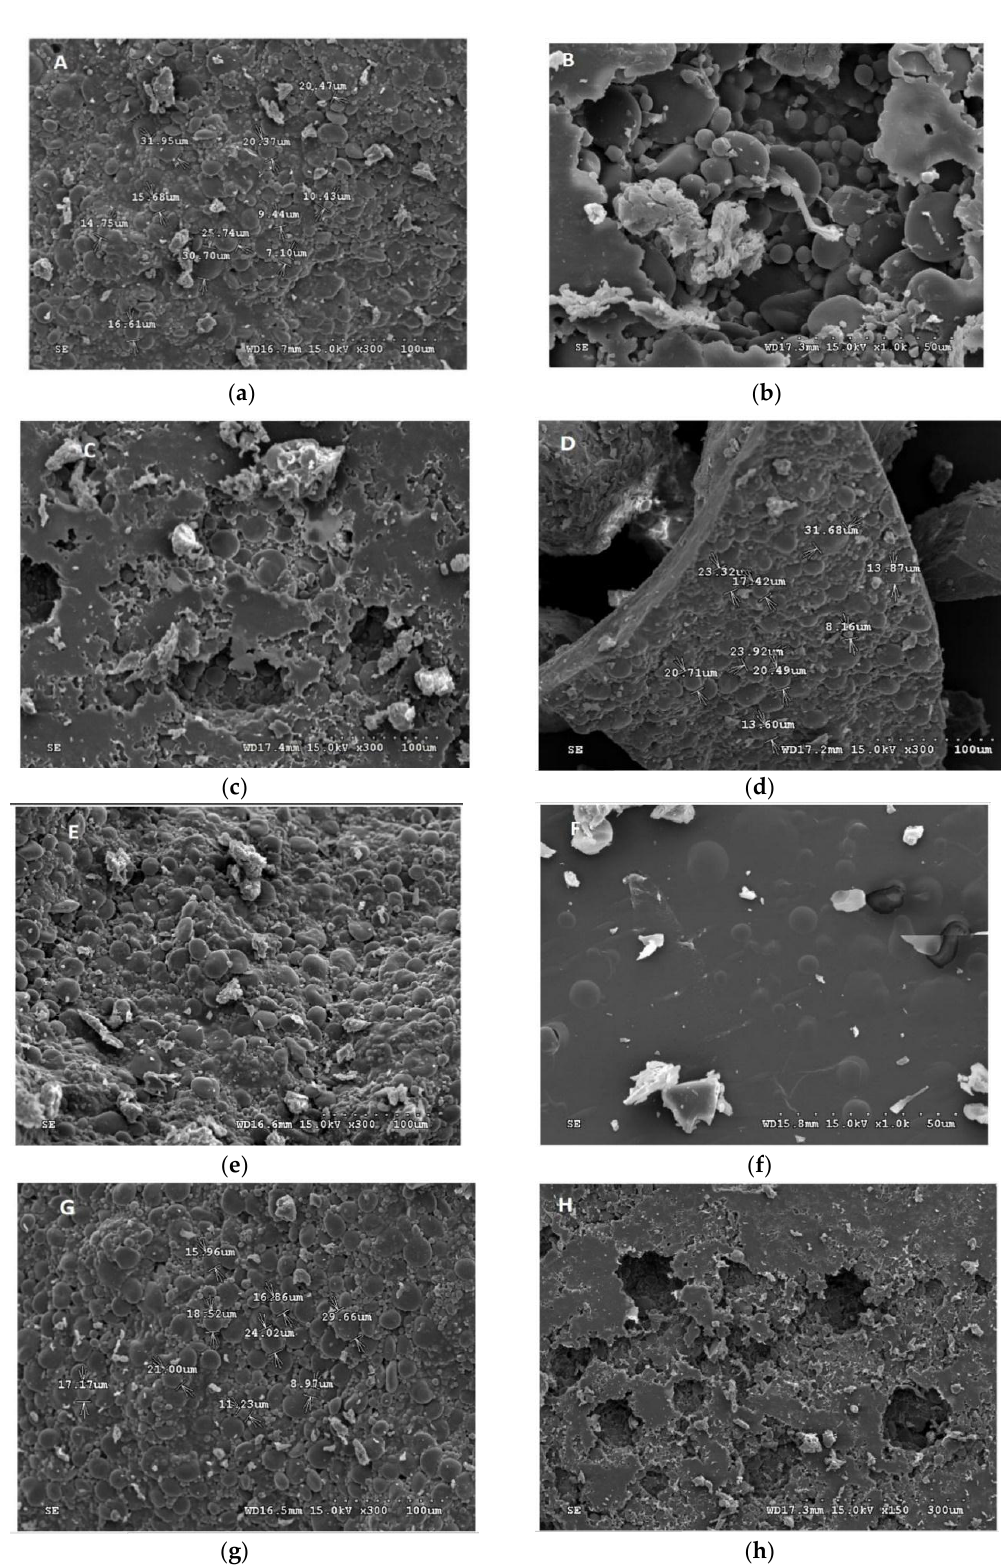
Figure 1. Scanning electron micrograph (SEM) of freeze dried ( a ) L. plantarum , ( b ) L. paraplantarum , ( c ) W. paramesenteroides , and ( d ) E. faecalis .